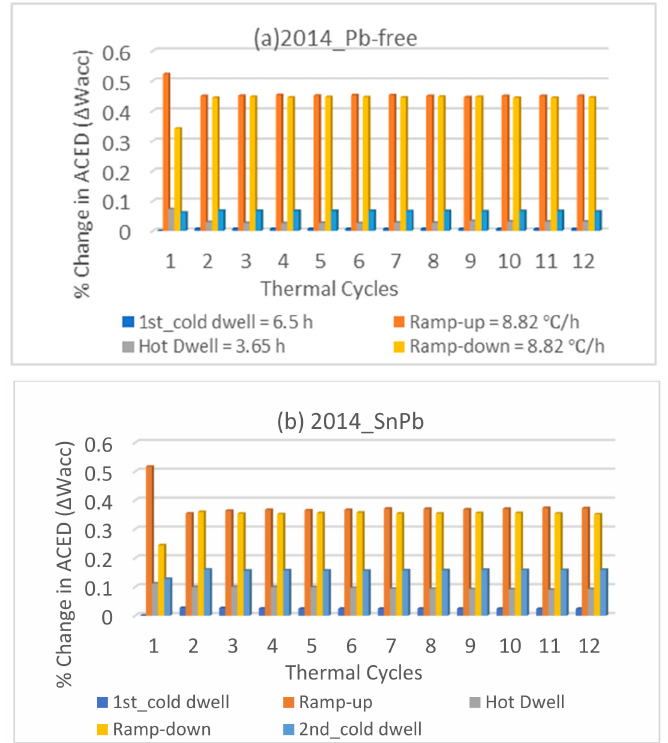
Figure 8. Change in ACED distribution from 2013 thermal cycle for: ( a ) Pb-free, ( b ) PbSn intercon-